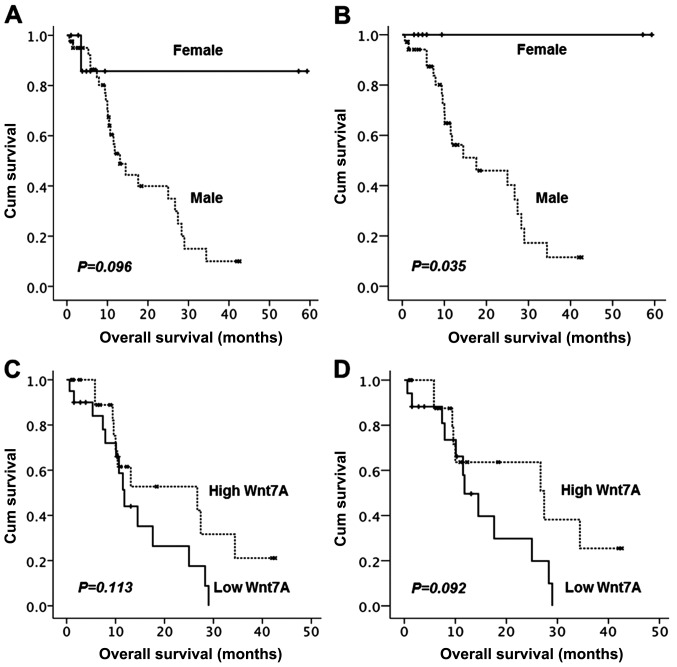
Kaplan-Meier survival curves according to gender and Wnt7A expression. (A) Overall survival of all patients (n=50) according to gender. (B) Overall survival of patients with epithelioid tumors (n=42) according to gender. (C) Overall survival of male patients (n=41) according to Wnt7A expression. (D) Overall survival of male patients with epithelioid tumors (n=35) according to Wnt7A expression.